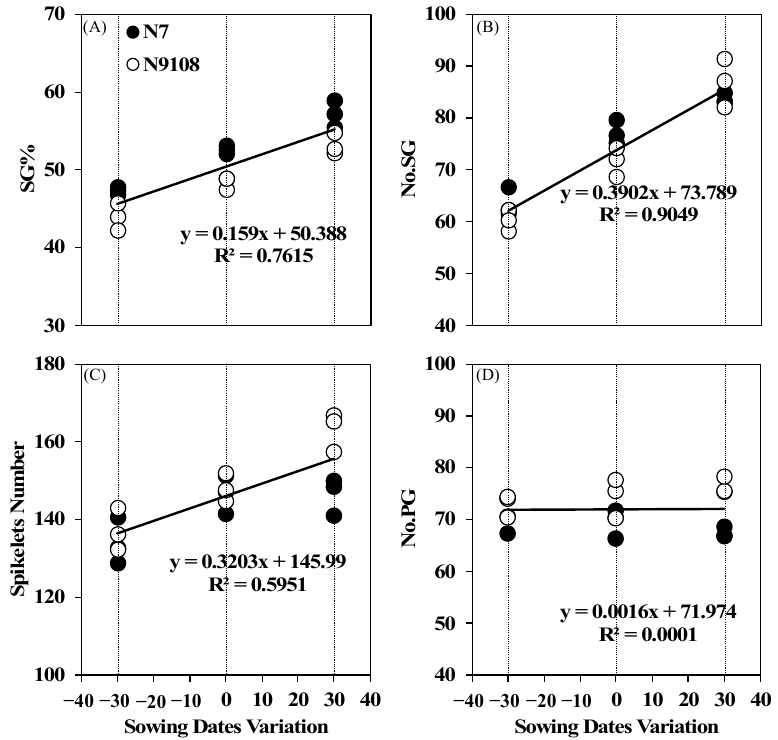
Figure 6. Spikelets structure of N7 and N9108 in different sowing date treatments. ( A ): Ratio of grains in secondary branches per unit area (SG%); ( B ): Number of grains in secondary branches per panicle; ( C ): Spikelets number panicle; ( D ): Number of grains in primary branches per